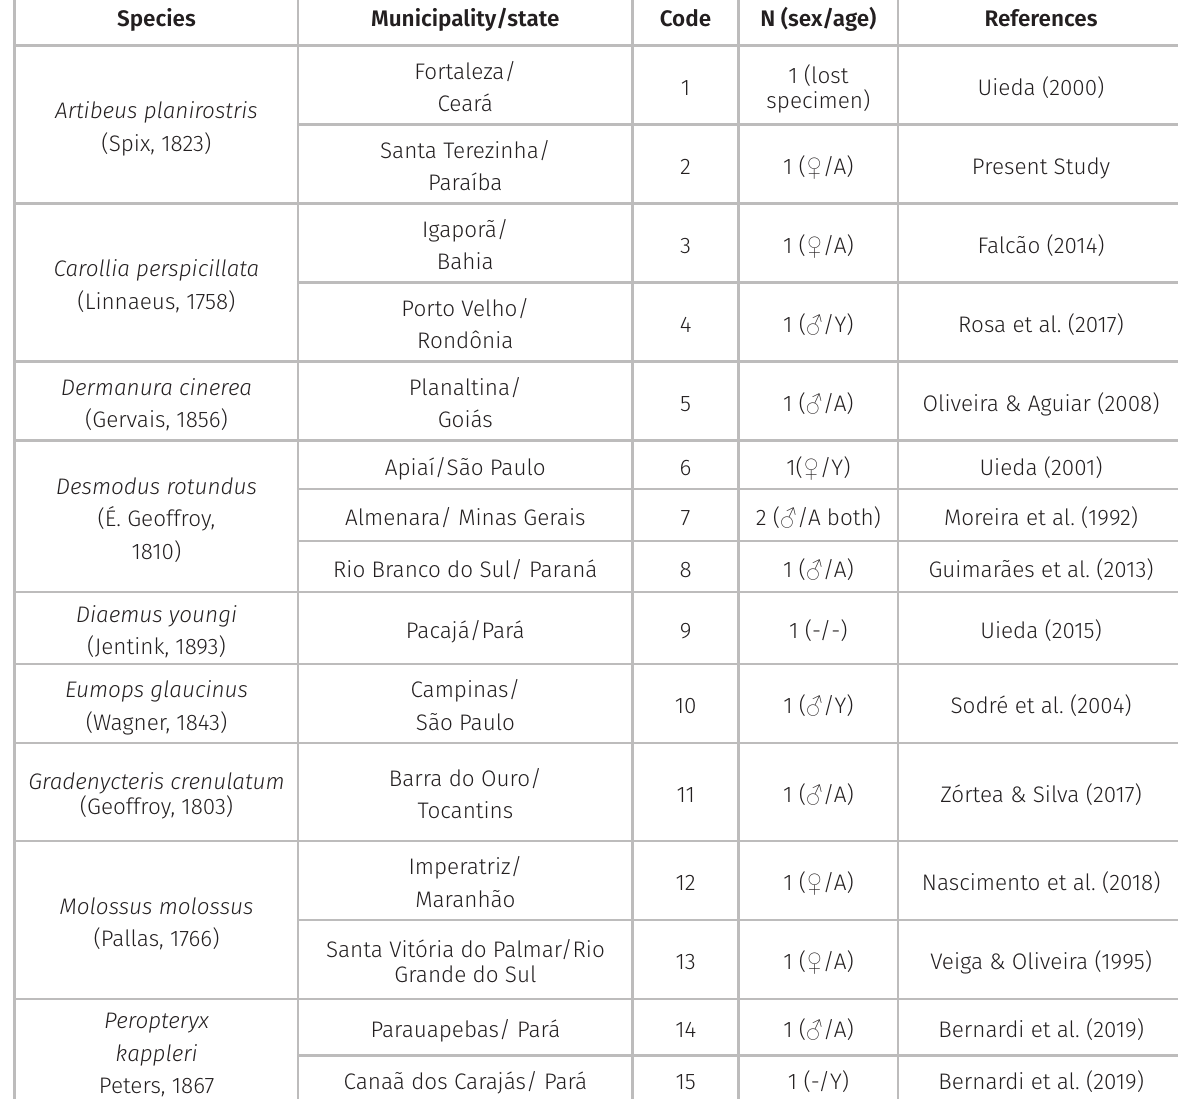
Table I. Species, localities, sex and ages of the albino bats recorded in Brazil. Codes refer to numbers indicated in Figure 2. N=number of individuals, A=adult, and Y=